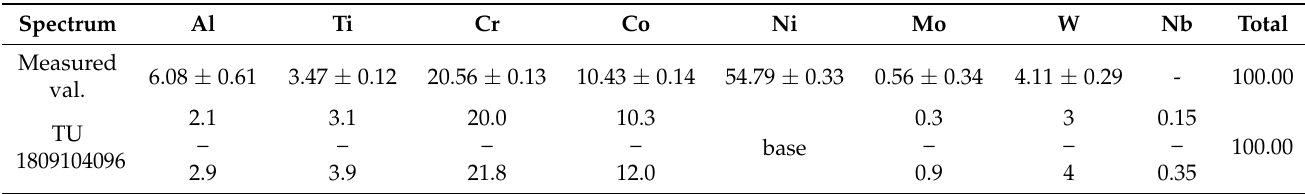
Table 3. Chemical composition of Ni-Cr-Al-Ti superalloy